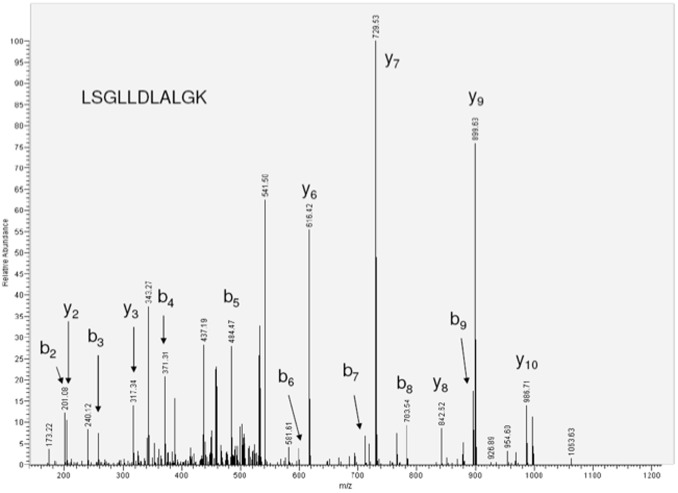
Tandem MS spectrum of MHC I-associated peptide, LSGLLDLALGK, originated from salivary amylase.